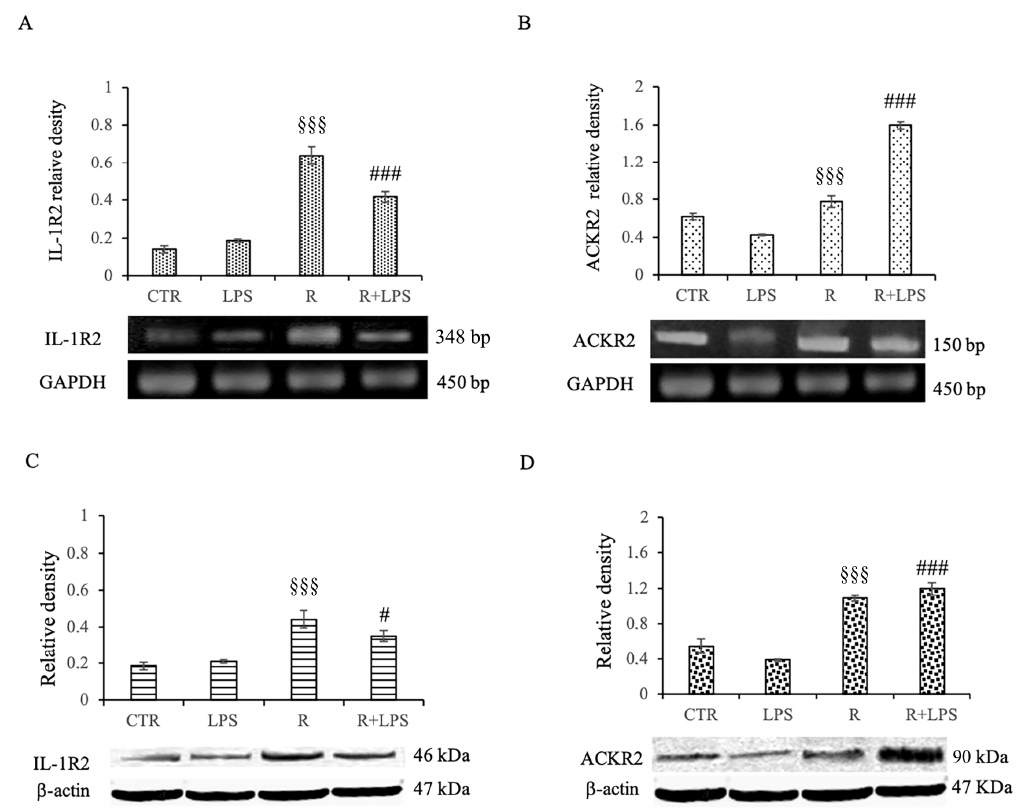
Figure 7. Effects of resveratrol on the decoy receptors mRNA and protein expression levels. N13 microglial cells were pre-incubated in medium containing resveratrol (10 μ M) for 1 h, and then treated with LPS (100 ng/mL) for 72 h. PCR analysis of IL-1R2 ( A ) and ACKR2 ( B ) mRNA expression in untreated cells (CTR), N13 cells treated with resveratrol alone (R), LPS alone (LPS), and LPS and resveratrol (R + LPS). Results are presented as arbitrary units after normalization against GAPDH, which was used as the resident control. Western blotting detection and densitometric analysis of IL-1R2 ( C ) and ACKR2 ( D ). For protein expression analysis, the values are expressed as arbitrary units after normalization against β -actin, which was used as a loading control. Results are expressed as means ± SD of five independent experiments. §§§ p < 0.001 R vs. LPS; ### p < 0.001 R + LPS vs. LPS, # p < 0.05 R + LPS vs.